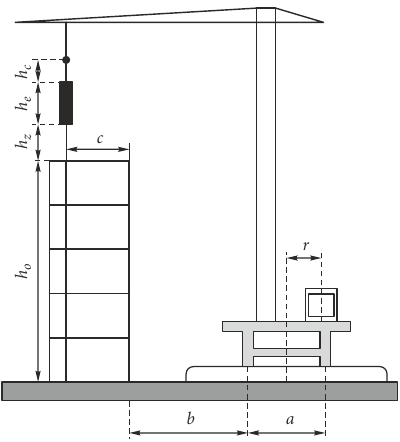
Figure 6. A schematic view of determining the parameters of the tower cranes